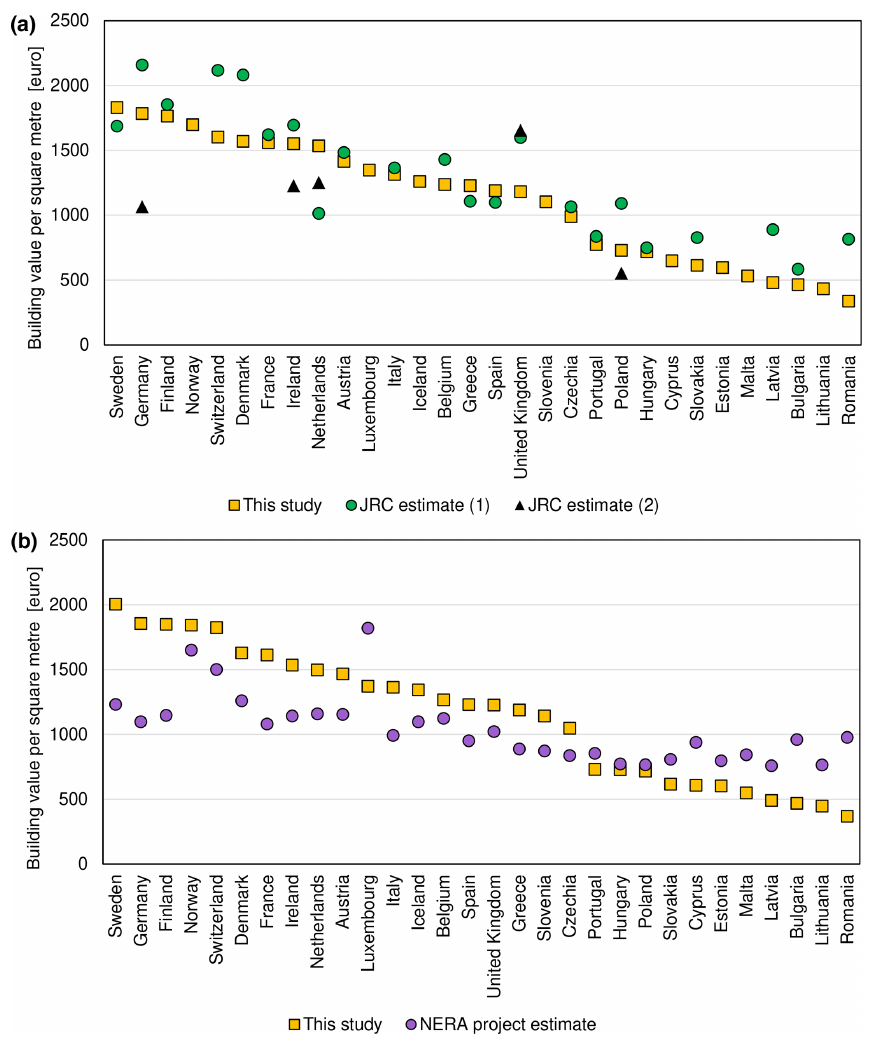
Figure 8. Comparison of residential building values per square metre of floor space estimated in this study with (a) two estimates by the Joint Research Centre (Huizinga et al., 2017) for the year 2010 and (b) estimates from the NERA project (Ozcebe et al., 2014) for the year